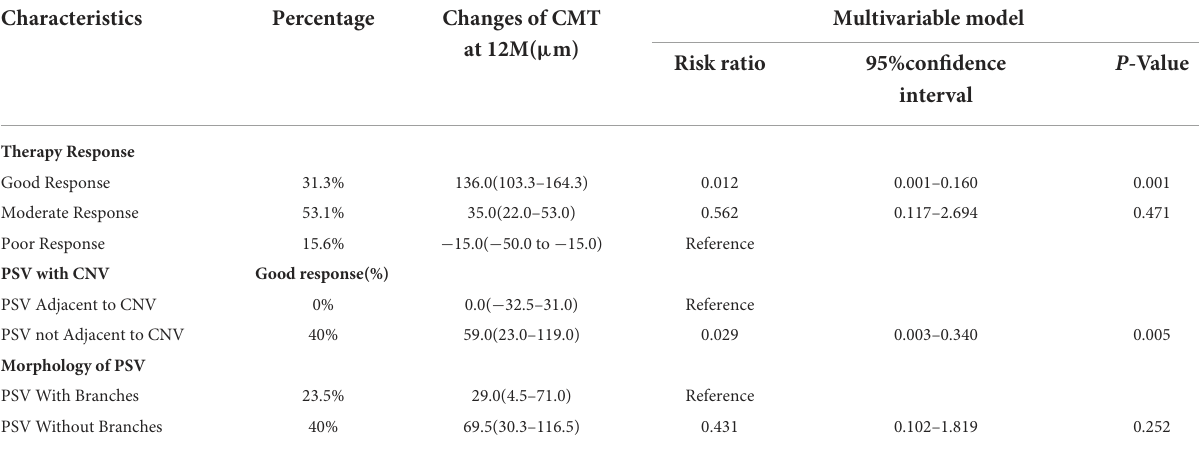
TABLE 3 Risk of therapy response at 12 months after intravitreal anti-VEGF and risk ratios associated